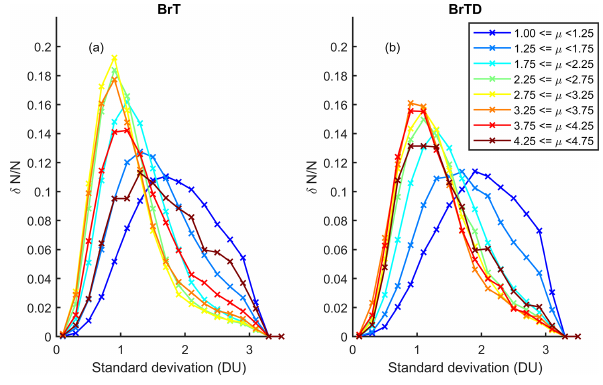
Figure A1. The distribution of the standard deviations of individ- ual DS measurements as a function of air mass value. Panel (a) shows the Brewer reference triad (BrT) data (1999–2019), and panel (b) shows the double-Brewer reference triad (BrT-D) data (2013–2019). Data from all three Brewers for each triad were used for this plot.